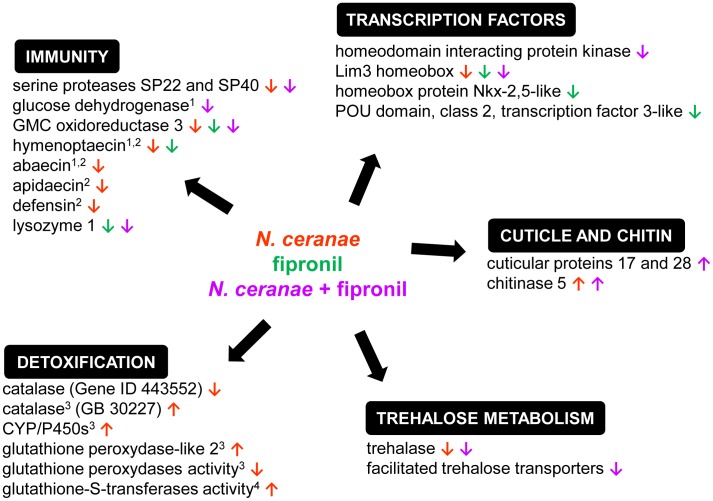
Impact of N. ceranae and fipronil on gene expression or enzyme activity in the honeybee.The figure presents a selection of genes or enzymes whose expression or activity has been shown to significantly increase (↑) or decrease (↓) under exposure to N. ceranae (red), to fipronil (green), or to a N. ceranae-fipronil combination (purple) in the present work or in previous studies: 1Antunez et al., 2009; 2Chaimanee et al., 2012; 3Dussaubat et al., 2012; 4Vidau et al., 2011.